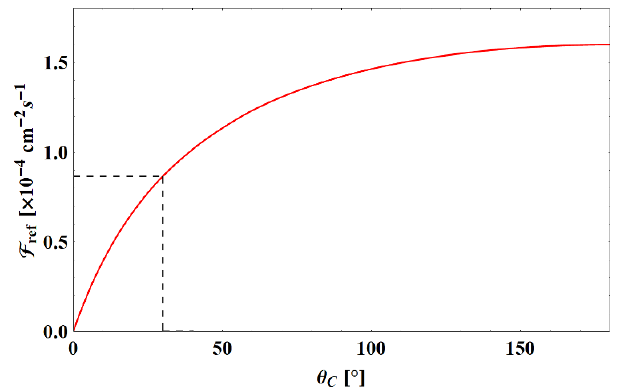
Figure 4 . F ref as a function of (cid:18) C . F 180 (cid:14) NFW DM halo pro(cid:12)le [28,